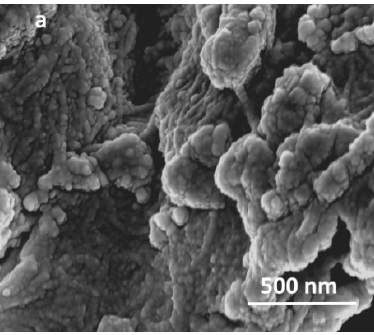
Figure 6. ( a ) SEM and ( b ) TEM images of the SWCNT/SiPc hybrid material.